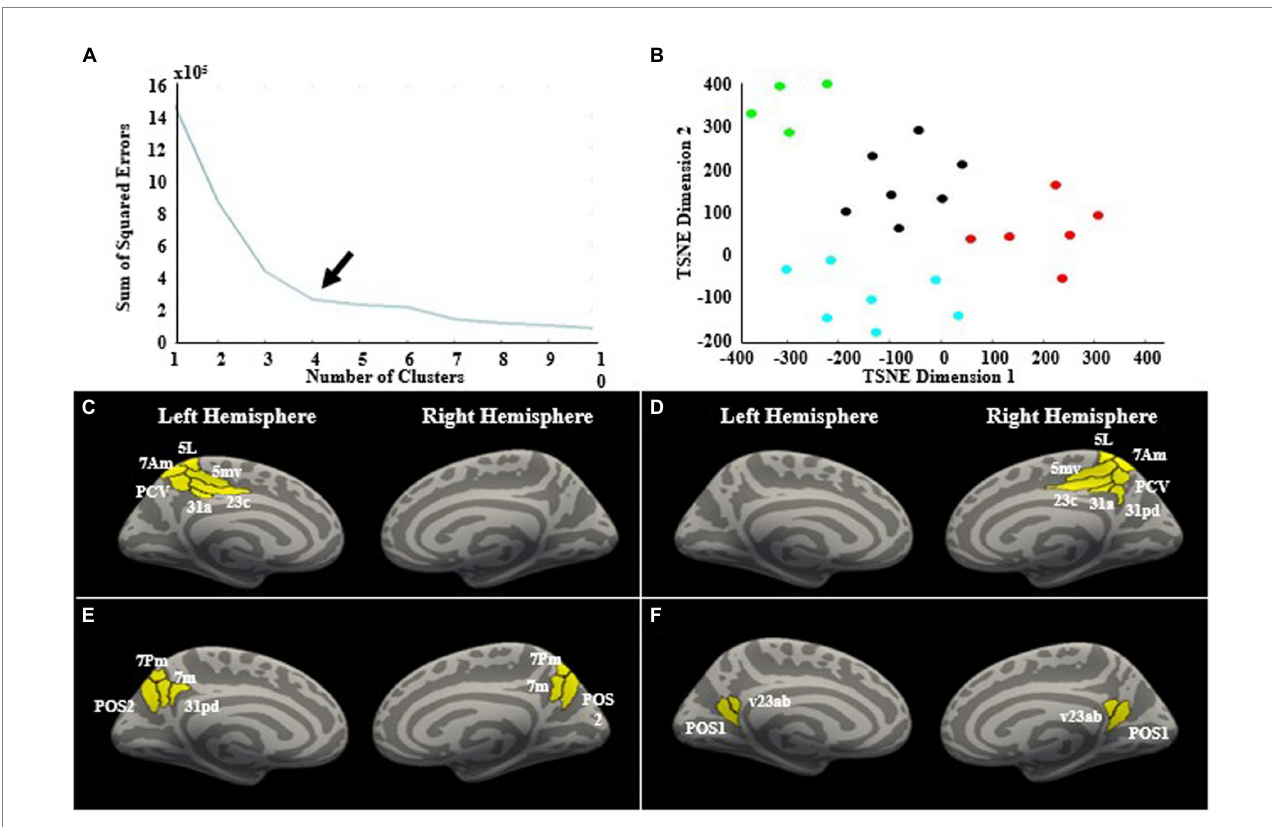
FIGURE 5 Cluster analysis. (A) K-means clustering and the elbow-method was used to determine the optimal number of clusters, which was determined to be four clusters, indicated by the arrow. (B) The two-dimensional t-SNE plot with each point representing a precuneus subregion. Each region’s location on the plot is determined by the region’s whole-brain connectivity profile in the theta band. If regions have more similar connectivity profiles, they will be located closer to each other on the t-SNE plot. The clusters are denoted by different colors. The four clusters are shown on the cortical surface. There was a left hemisphere cluster (C) , a right hemisphere cluster (D) , and two bilateral clusters (E,F)